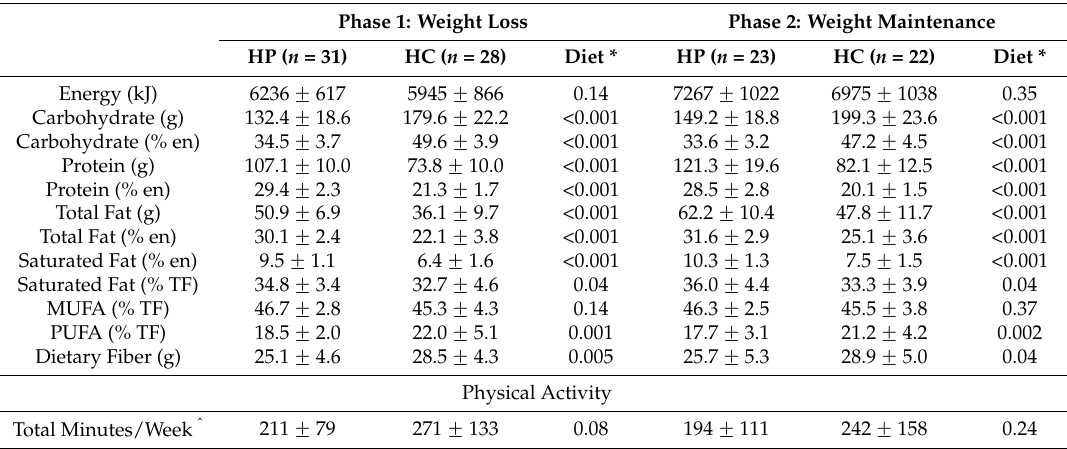
Table 2. Energy, macronutrient composition, and physical activity results following weight loss (week 12) and weight maintenance (week 24) phases by dietary patterns.